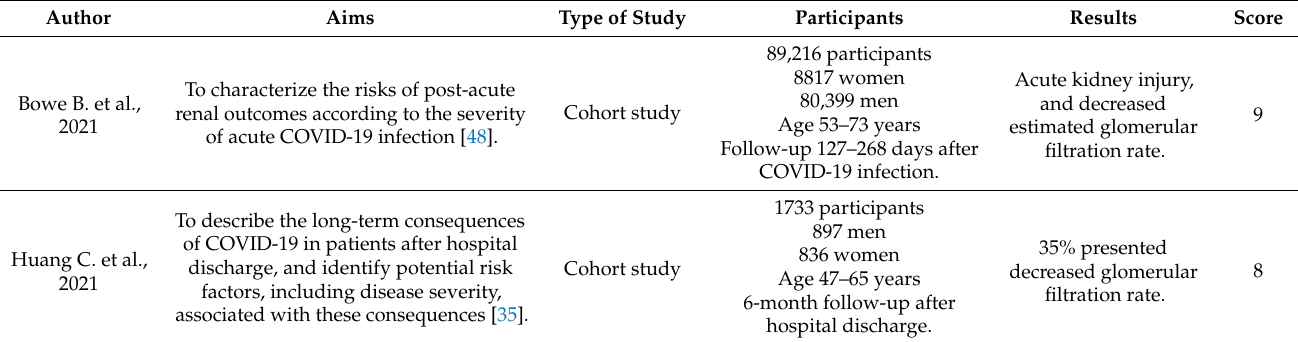
Table 3. Summary of literature mentioning renal